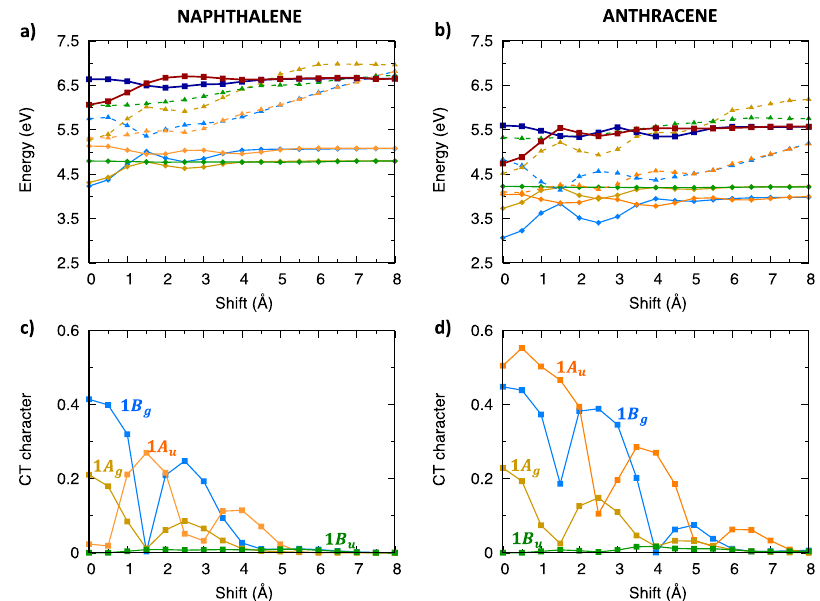
Figure 4. Lowest energy singlet exciton states of (left) naphthalene and (right) anthracene: ( a , b ) adiabatic excitation energy profiles of the low-lying exciton states depicted with different color codes for different symmetries: yellow for 𝐴 𝑔 , orange for 𝐴 𝑢 , blue for 𝐵 𝑔 and green for 𝐵 𝑢 . The lowest energy exciton states not included in the diabatization procedure are also shown (dark blue, 𝐵 𝑔 symmetry, dark red, 𝐴 𝑢 symmetry), ( c , d ) 𝐶𝑇 character of the lowest four exciton states.